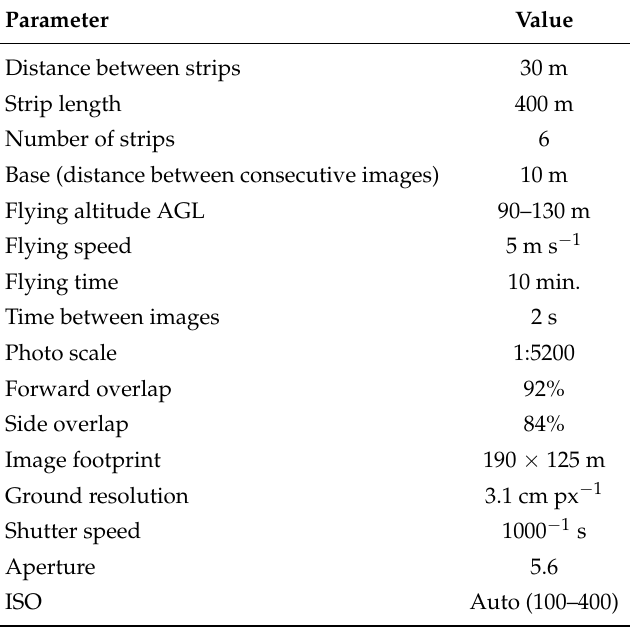
Table 2. The parameters of the flight trajectory and image acquisition; the values that depend on the flight altitude (AGL) are stated for the average